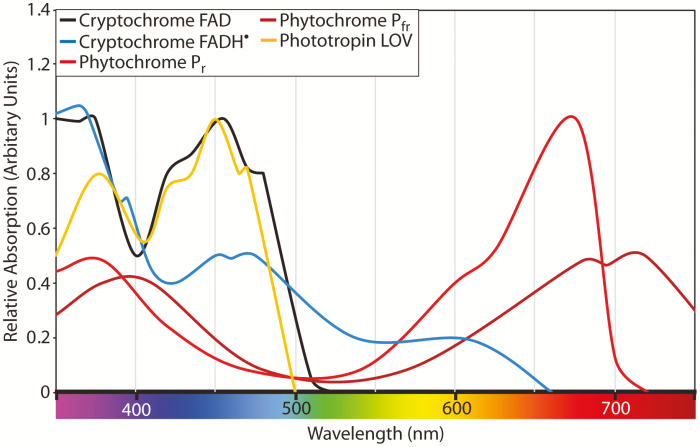
Absorption spectra for phytochrome, cryptochrome, and phototropin. Spectra are approximately re-drawn from primary sources from Butler et al. (1964), Banerjee et al. (2007), and Jones et al. (2007).